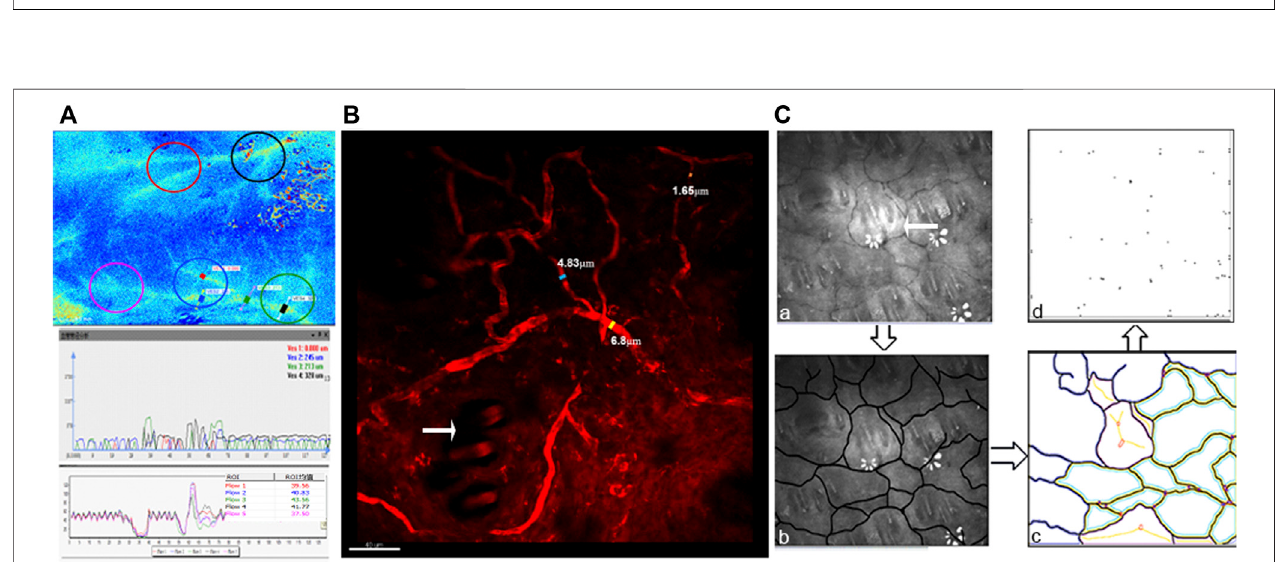
FIGURE2| Observationofbloodperfusion,capillarynetwork,andskinthicknessindifferentregionsofthebackskin: (A) Imageofthebackoftherat;thebackwas divided into six regions by the black line: (A) Upper left region; (B) upper right region; (C) middle left region; (D) middle right region; (E) lower left region; (F) lower right region. (B) Blood perfusion image of the rat back (The red box area is the selected observation area). (C) Statistical chart of blood perfusion; data are expressed as mean ± SD (n = 3) ( ### p < 0.001 vs. middle right region and *** p < 0.001 vs. left side); (D) OCT image of the back skin. (E) Statistical chart of OCT intensity; data are expressed as mean ± SD (n = 3) ( ## p < 0.001 vs. upper region). (F) LDA image of the capillary network.